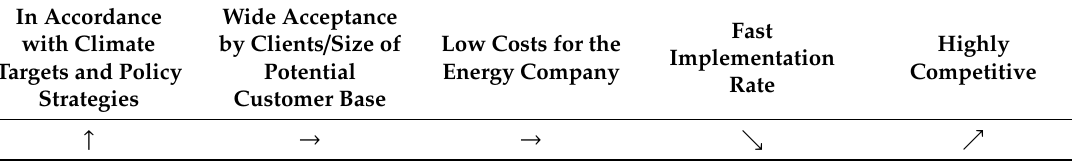
Table 8. Assessment of virtual power plants as a business model for energy